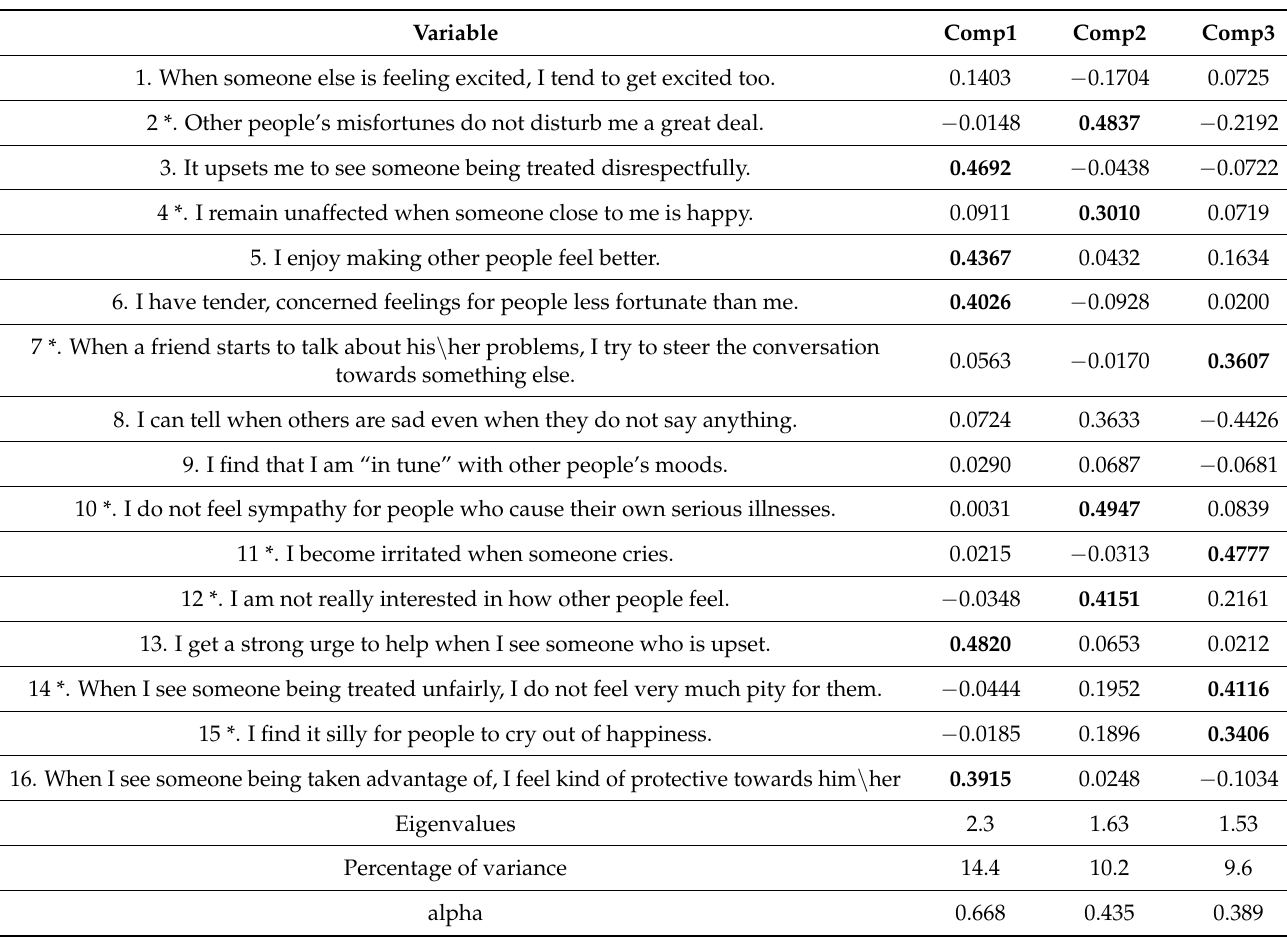
Table 4. Factor loading for the three components after varimax